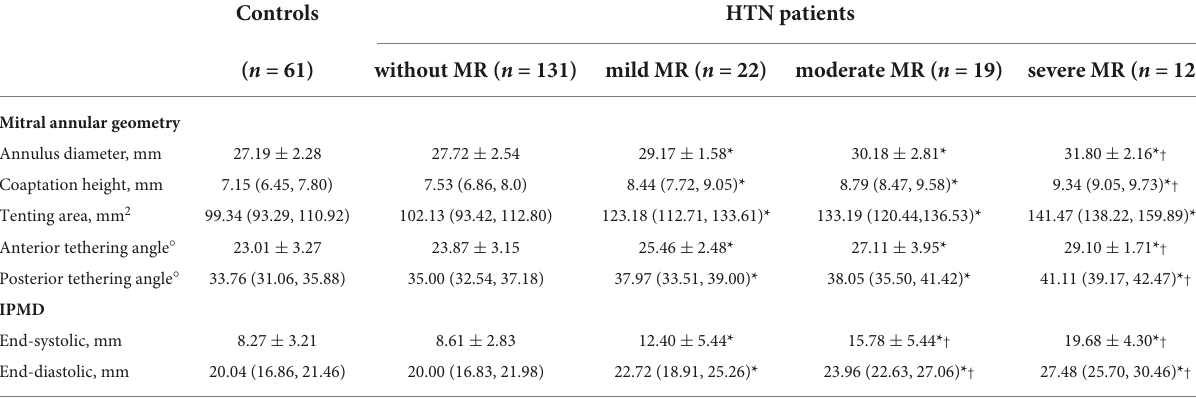
TABLE 4 Comparison of mitral annular geometry and interpapillary muscle distance among different groups.